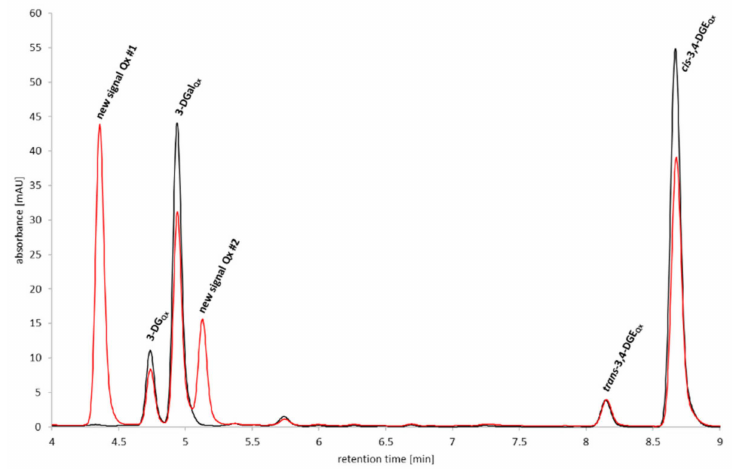
Figure 2. Incubation of 3,4-dideoxyglucosone-3-ene (3,4-DGE) with L -glutathione (GSH) leads to the formation of two new signals. 3,4-DGE (165.0 µ M) was incubated either without (black curve) or with (red curve) 91.0 µ M GSH at 37 ◦ C for 24 h and analyzed by UHPLC-DAD at 316 nm after derivatization with ortho -phenylenediamine ( o -PD). An excerpt of the chromatogram is shown; the identified compounds are labeled. The UV-spectra are depicted in Scheme 1; the characteristic quinoxaline-UV-spectra of the new signals, Qx #1 and Qx #2, indicate the presence of dicarbonyl compounds. Qx,